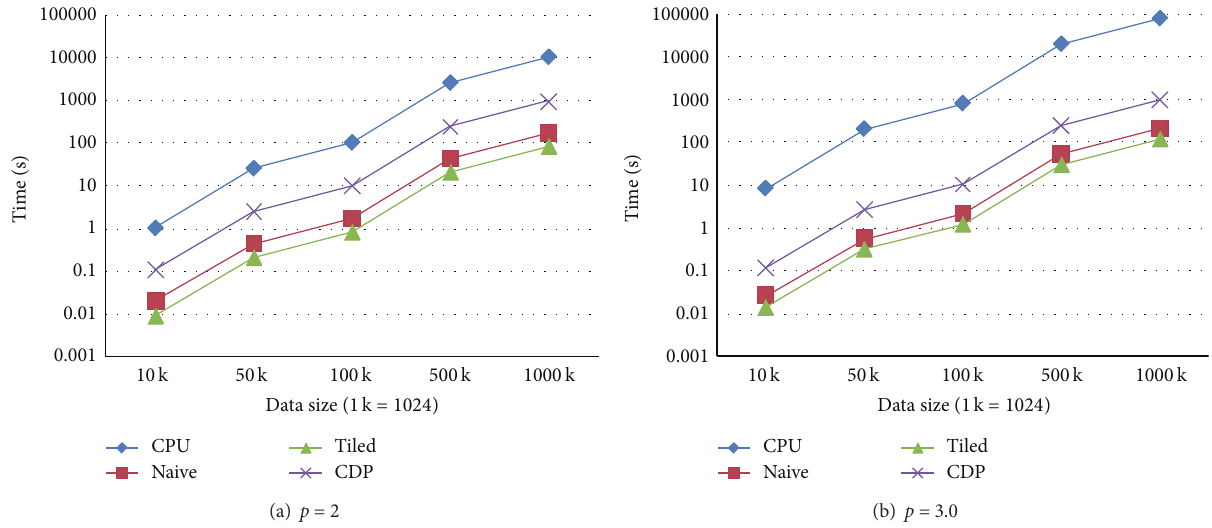
Figure 2: Execution times in the test case when the numbers of prediction points and data points are identical. (a) The form in which the power parameter is set to 2. (b) The form in which the power parameter is set to